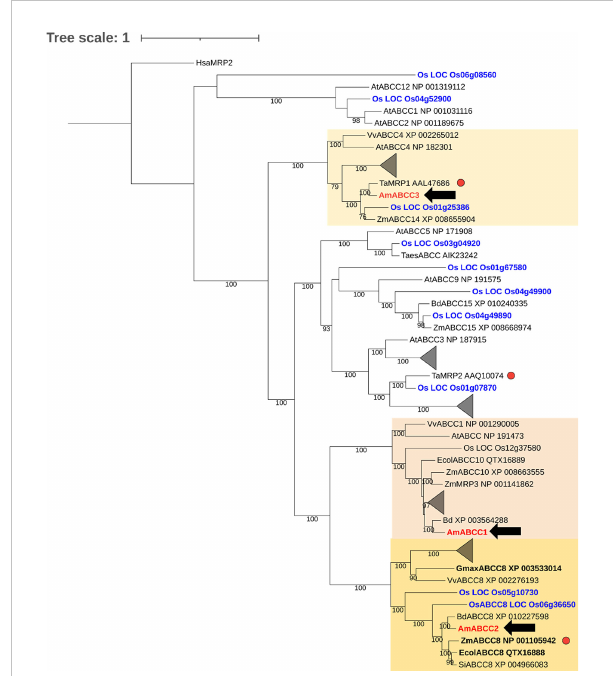
FIGURE 9 Phylogenetic analysis of ABCC proteins in grass weeds and crop plants. Amino acid sequences of Am ABCC1, Am ABCC2, and Am ABCC3 from blackgrass (Am , Alopecurus myosuroides ; red), rice (Os , Oryza sativa ; blue) wheat (Ta , Triticum aestivum ), maize ( Zm , Zea mays ), Arabidopsis ( At , Arabidopsis thaliana ), grape vine ( Vv , Vitis vinifera ), purple false brome ( Bd , Brachypodium distachyon) , jungle rice ( Ec , Echinochloa colona ), and foxtail millet ( Si , Setaria italica ) were used for maximum likelihood alignment for phylogenic analysis. The number on the branch represents the bootstrap support values above 75%. The scale bar indicates the inferred number of substitutions per site. Clades comprising exclusively rice and Arabidopsis sequences were collapsed into triangles. Sequences in bold correspond to proteins that confer resistance to glyphosate when enhanced in planta (Pan et al., 2021). Red dots indicate genes induced by safeners. The tree was rooted using the sequence of human MPR2 ( Hsa, homo sapiens